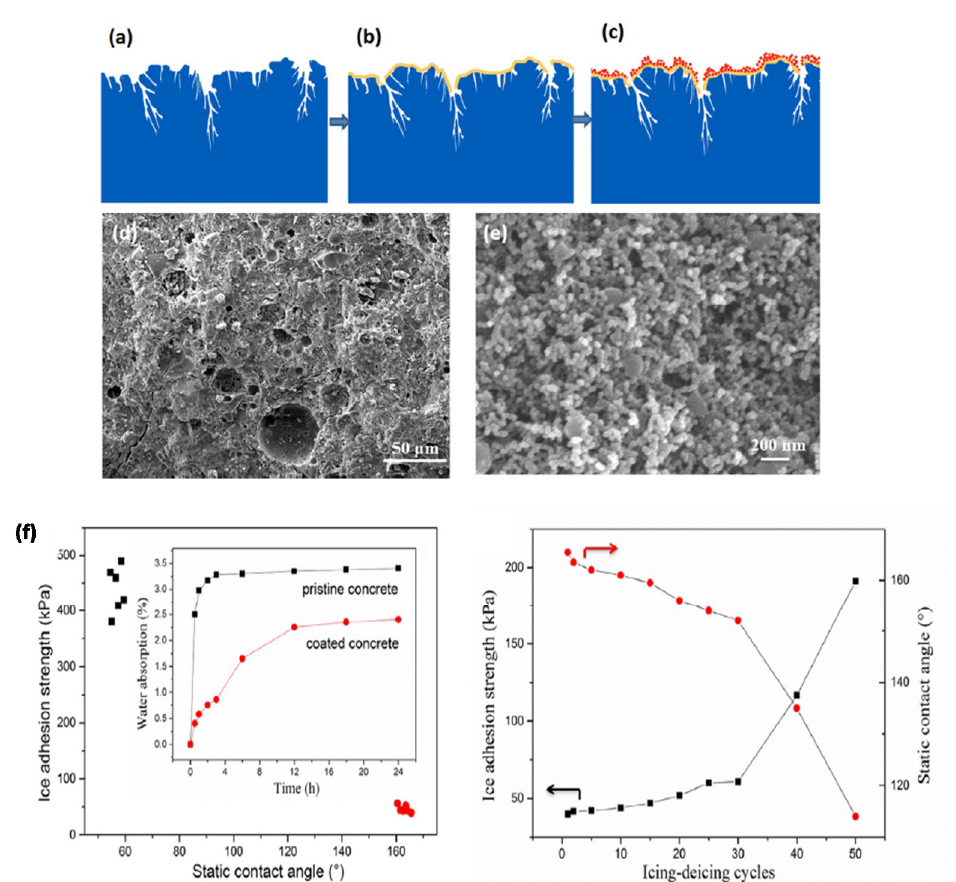
Figure 16. ( a – c ) Sketch depicting the generation of the hierarchical coating on the porous concrete surface; ( d , e ) SEM images of uncoated and coated concrete surface; ( f ) ice adhesion strength on coated and pristine concrete and its durability (on the right) upon icing–deicing cycles [42].